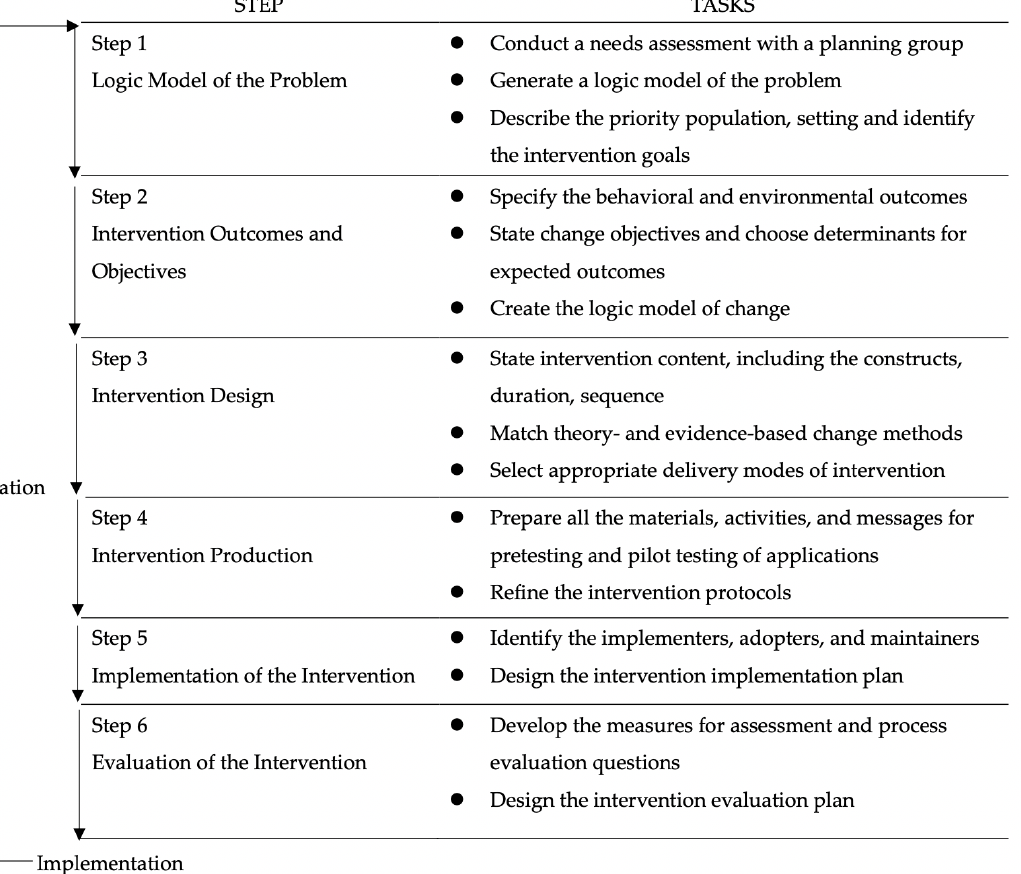
Figure 1. Intervention mapping steps and tasks (adapted with permission from Ref. [12]. 2016, Eldredge, L.K.B. Planning Health Promotion Programs: An Intervention Mapping Approach ).